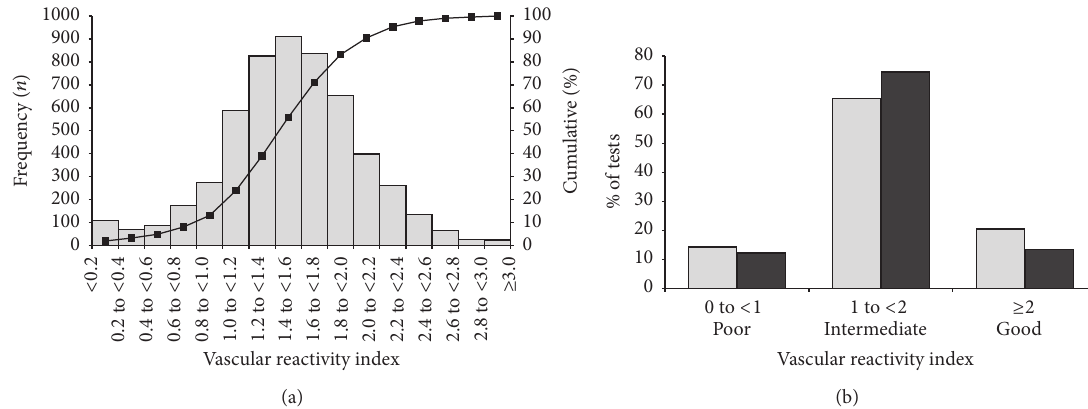
Figure 2: (a) Distribution of vascular reactivity index (VRI). A histogram and cumulative percentage curve are shown. (b) Distribution of vascular reactivity index (VRI) by gender. The percent of DTM tests falling into categories of poor, intermediate, and good vascular reactivity is shown for men (solid fill) and women (hatch fill).